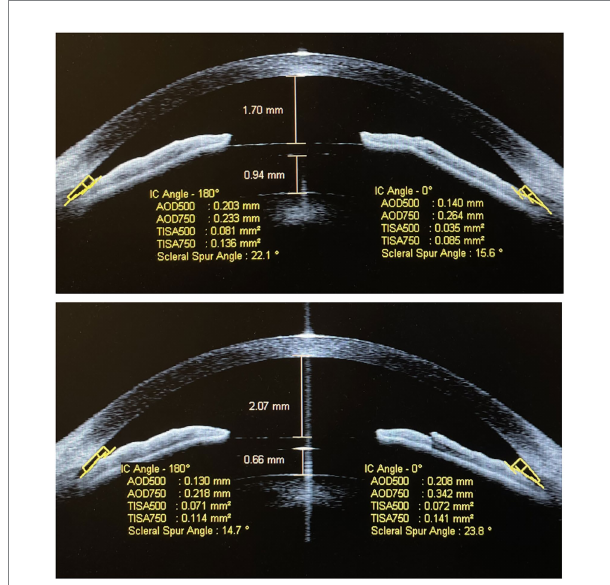
FIGURE 2 Anterior segment OCT image shows that the implantable collamer lens (ICL) vault was 940 μ m and the anterior chamber depth was 1,700 μ m before rotation (A) in patient A; 1 week after the rotation, the ICL vault was 660 μ m and the anterior chamber depth was 2,070 μ m (B) .